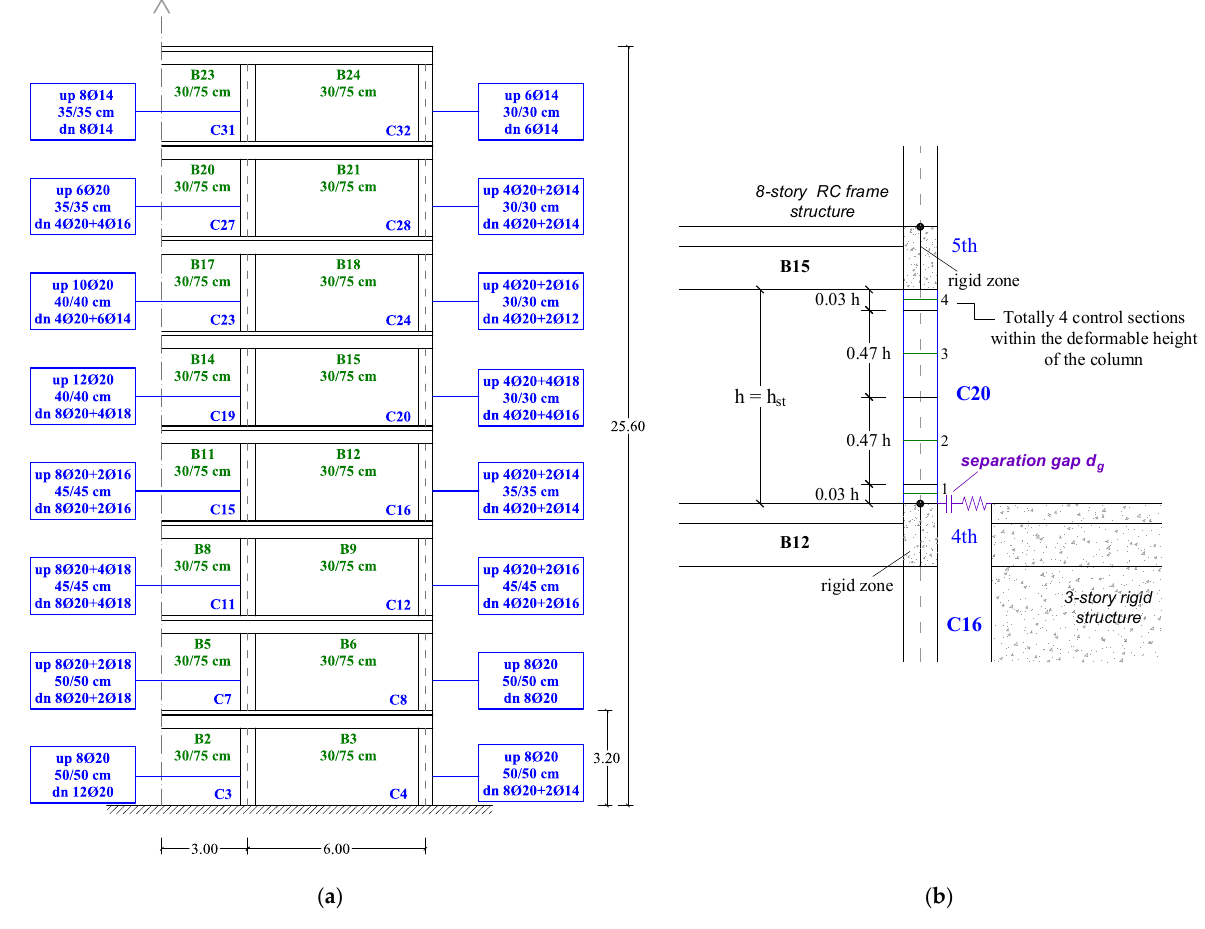
Figure 4. ( a ) Eight-story RC frame and ( b ) idealization of the contact area.